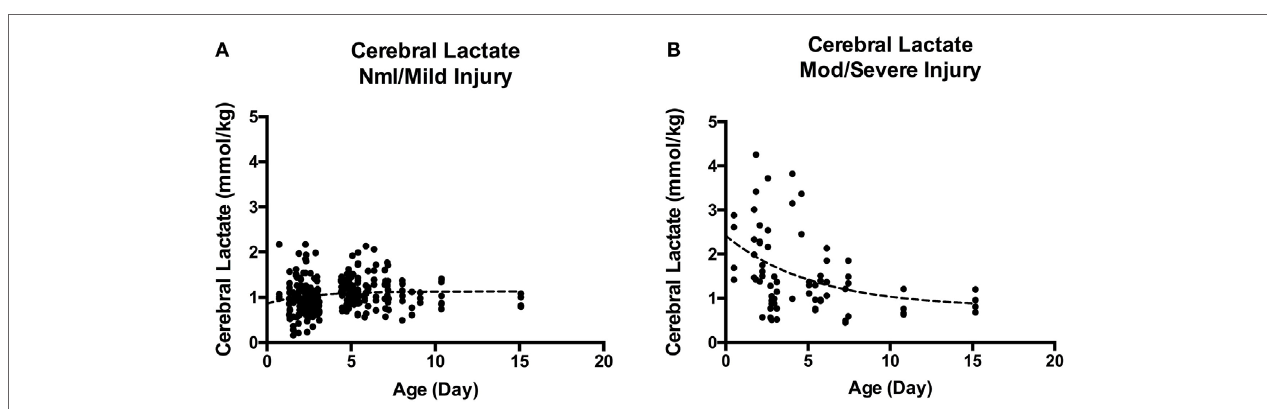
FigUre 2 | (a) Cerebral lactate over time in normal/mild injury. (B) Cerebral lactate over time in moderate-severe injury. A marked difference between cerebral lactate clearance in infants with nml/mild injury (a) vs. infants with mod/severe injury (B) . Although by 2 weeks of life, cerebral lactate trends toward 1 mmol/kg, it remains detectable.